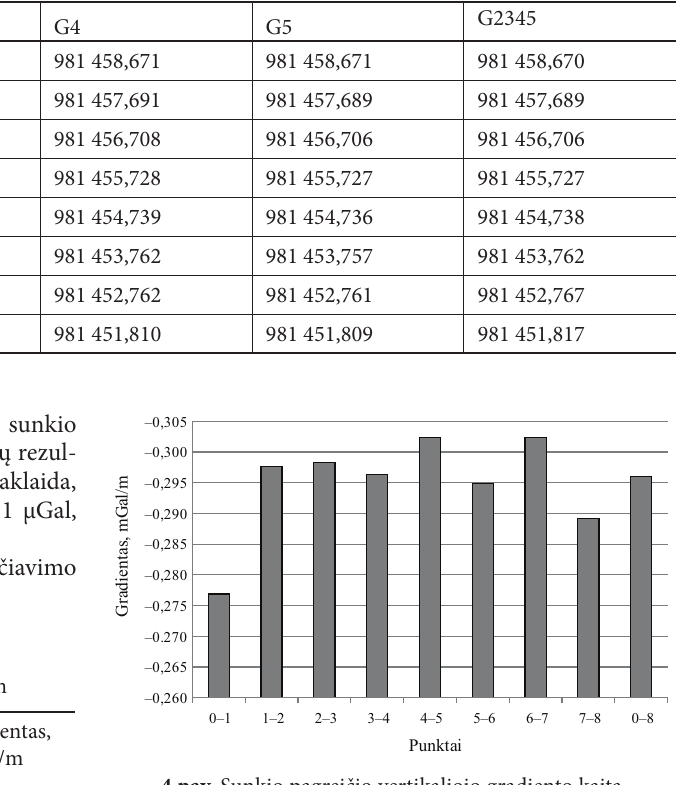
4 pav. Sunkio pagreičio vertikaliojo gradiento kaita Fig. 4. The changes of vertical gradient of gravity acceleration 4. Gravimetrų nulio slinkties tyrimai